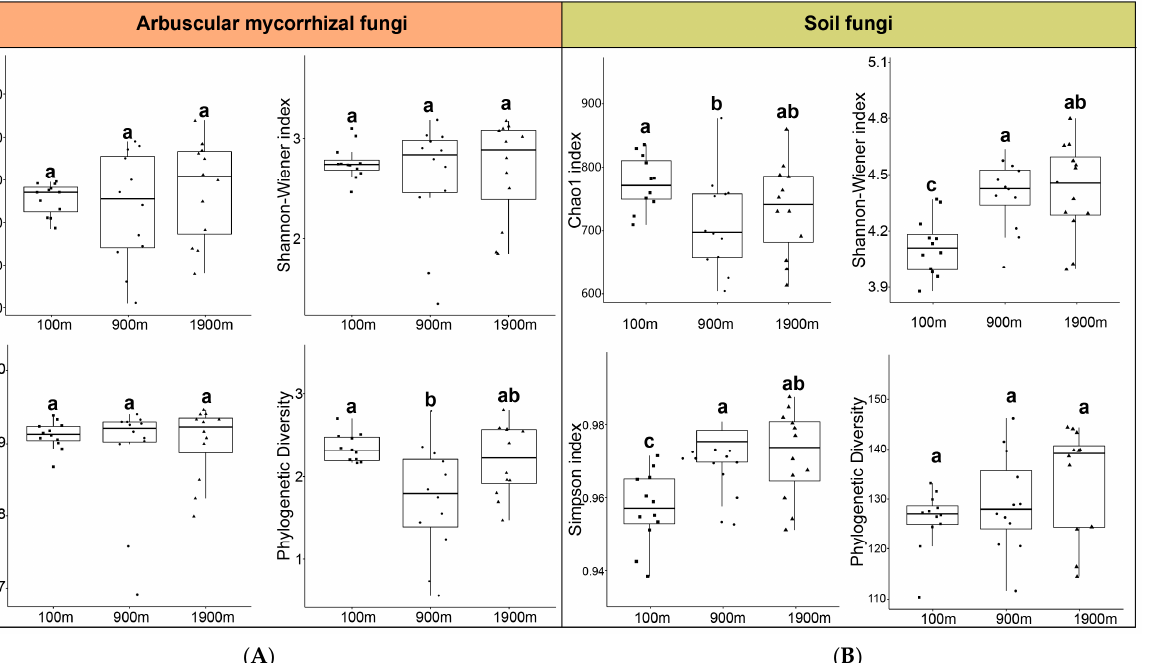
Figure 2. Effects of distance from coal-mine dump on the α -diversity of AMF ( A ) and soil fungal ( B ) communities. Rectangles, dots and triangles represent the values of diversity indices of replicate samples at different distances, respectively. Significantly different are bars followed by lowercase letters ( p < 0.05).